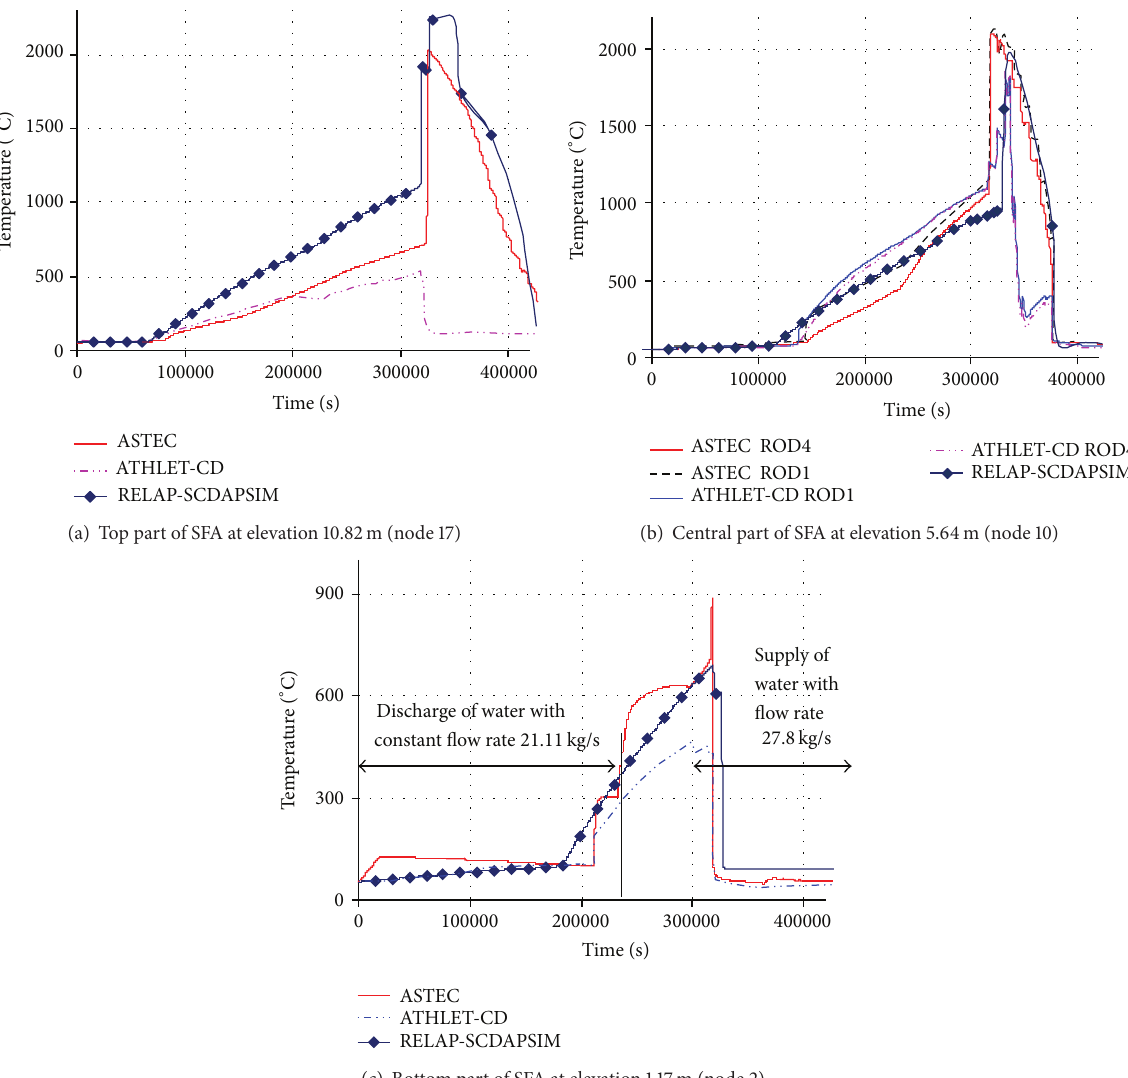
Figure 11: Fuel temperature in SFAs with different storage period at the different elevations calculated by using different codes (elevations from the bottom of